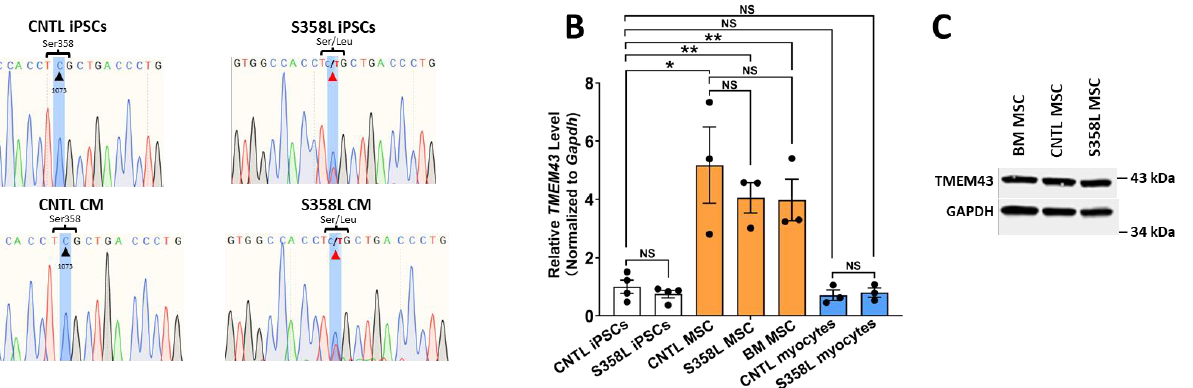
Figure 2. ( Panel A ) shows the DNA-sequencing results for control (CNTL) human iPSCs and patient S358L iPSCs and differentiated CNTL cardiomyocytes (CM) and S358L CM. ( Panel B ) shows the mRNA expression of TMEM43 in CNTL and S358L iPSCs ( n = 4) and differentiated MSC ( n = 3) and CM ( n = 3). ( Panel C ) shows that TMEM43 protein was highly expressed in bone marrow (BM) MSC, CNTL and S358L iPSC differentiated MSCs. (* p <0.05; ** p <0.01; ns, nonsignificant)